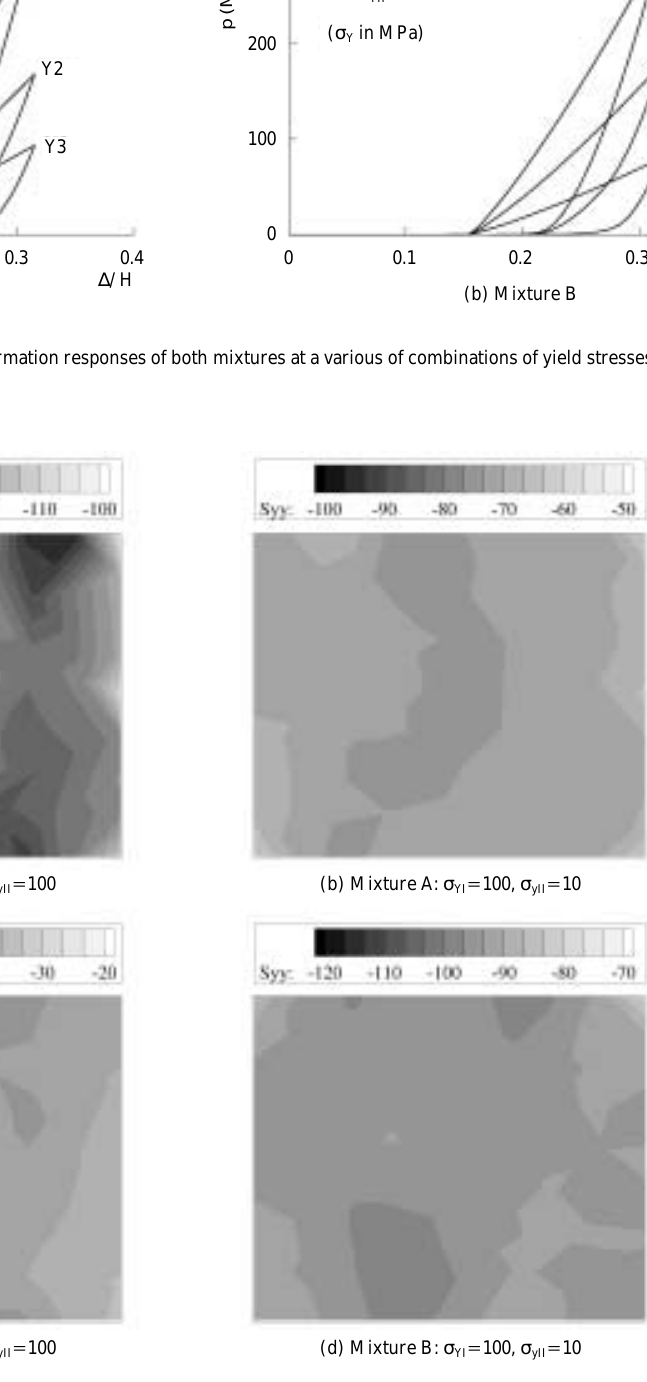
Fig. 9 The local stress contours of both mixtures at uniform Young’s modulus but various combinations of yield